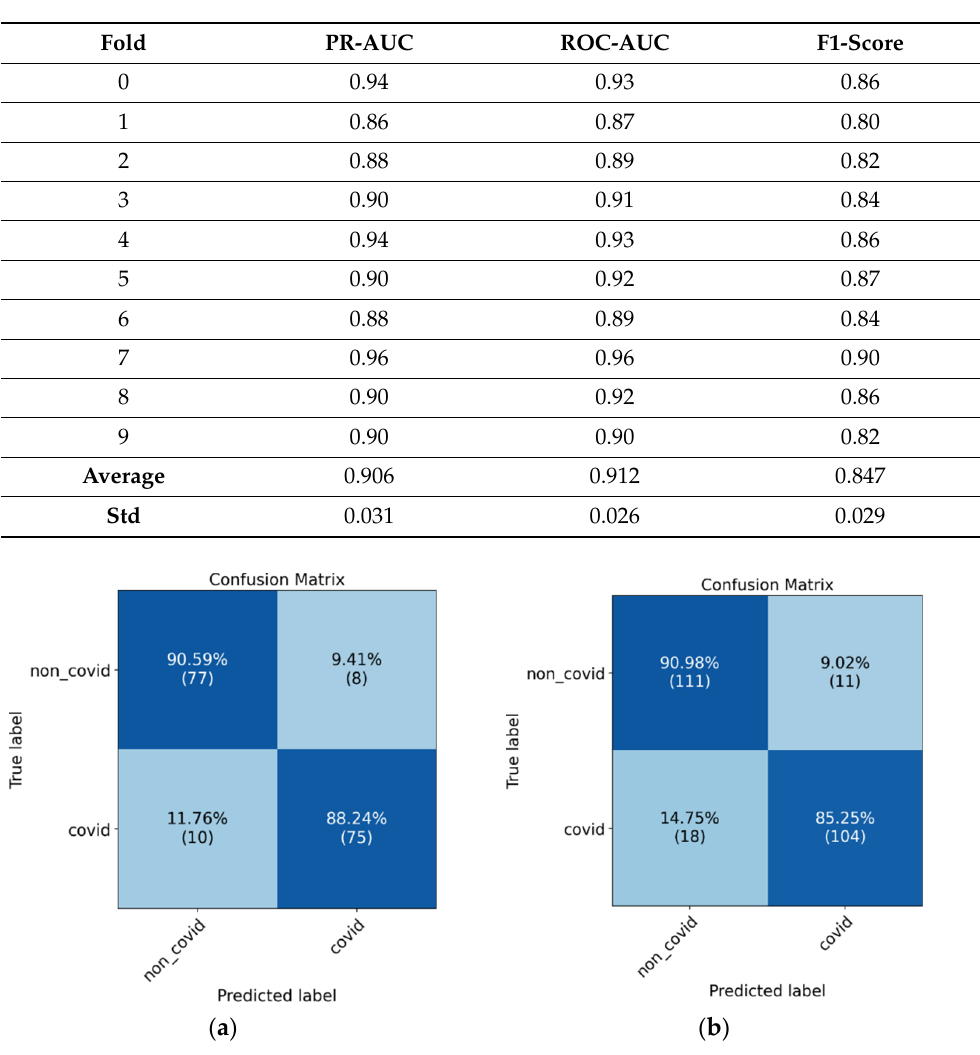
Table 5. Evaluation results for each validation fold.